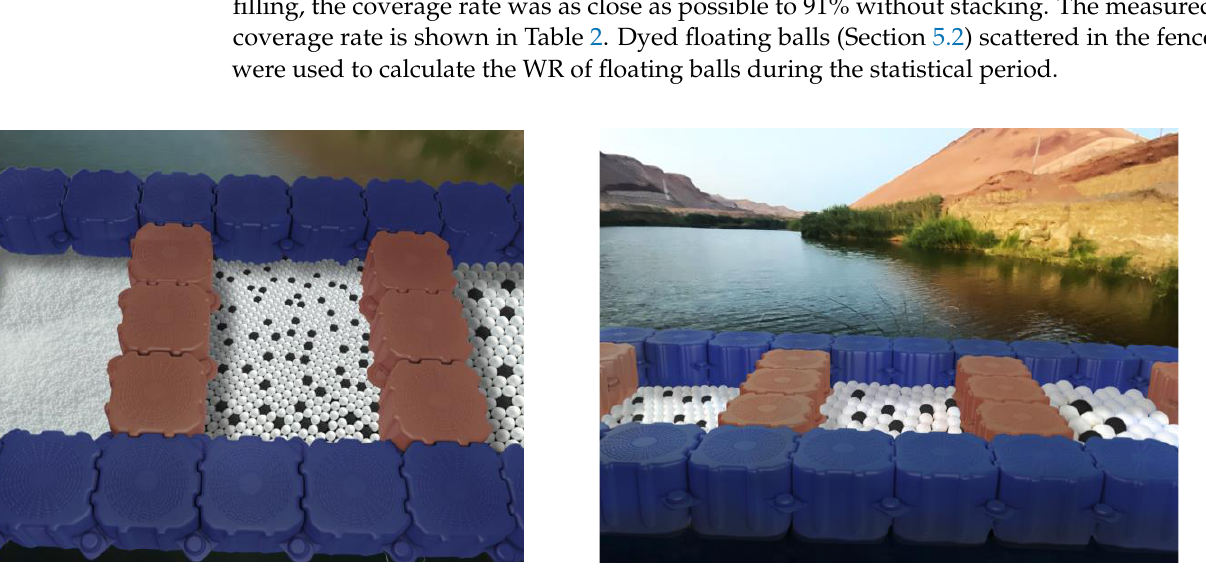
Figure 5. Wind and wave test layout. Table 2. Wind and wave test design.